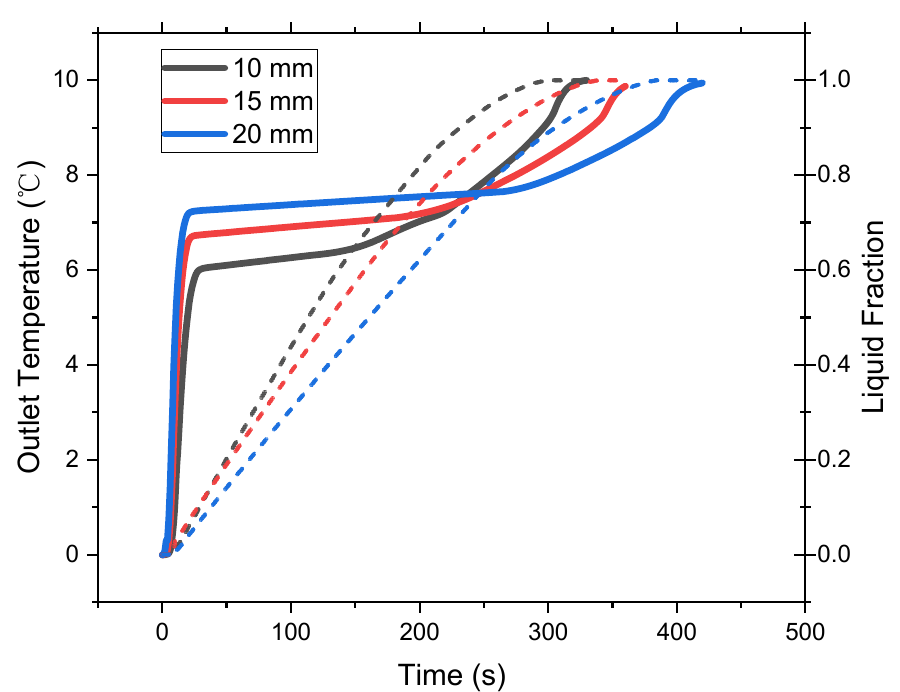
Figure 15. Discharge performance of cold storage tanks with different PCM thickness.